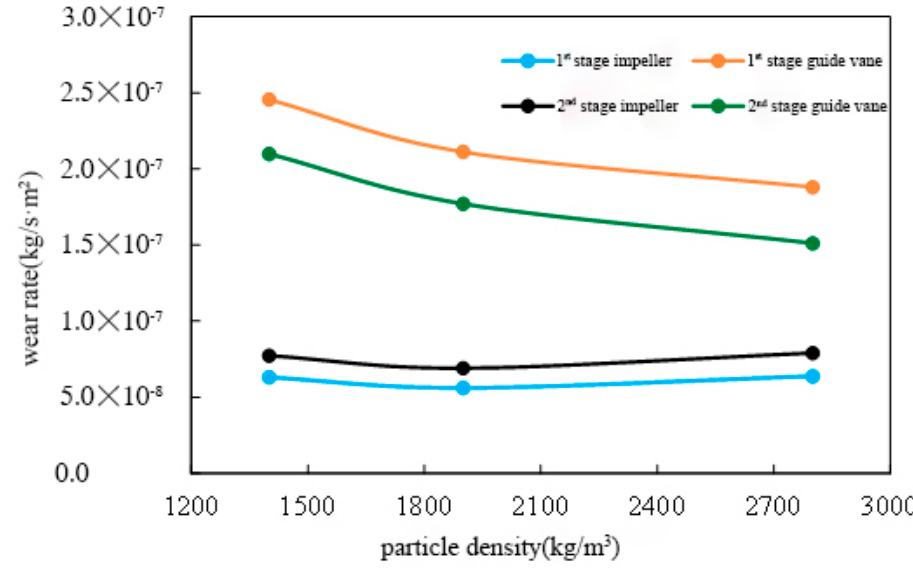
Figure 16. Wear rate changes on the surface of the through-passage components.